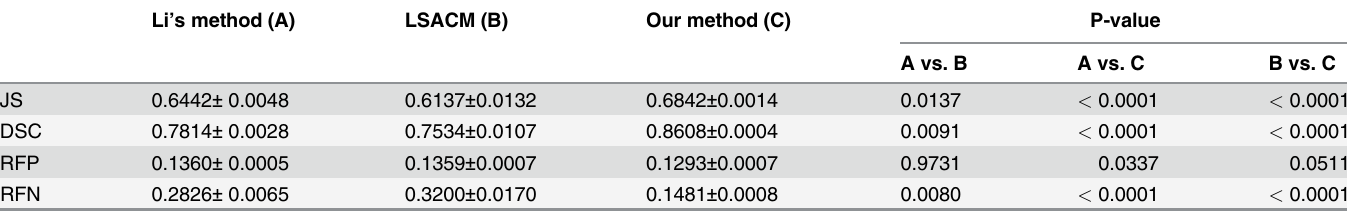
Table 4. Summary of Welchs t test analysis results of performance evaluations of GM segmentation quality between different methods (for 120 simulated MR image slices of the normal brain). Li ’ s method